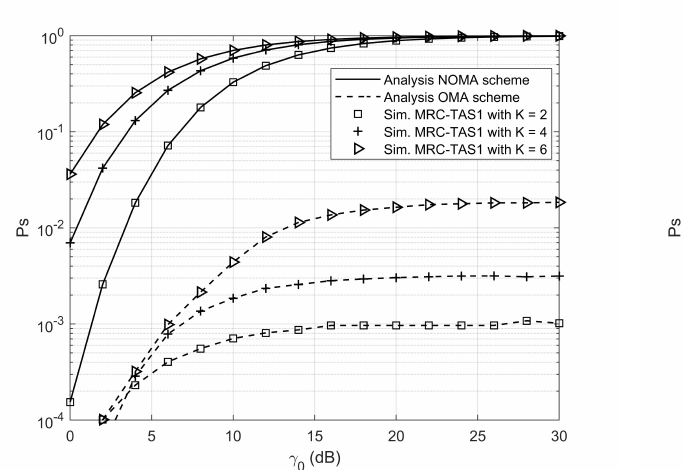
Figure 5. Impacts of the number of antennas K on Ps of MRC-TAS1 scheme